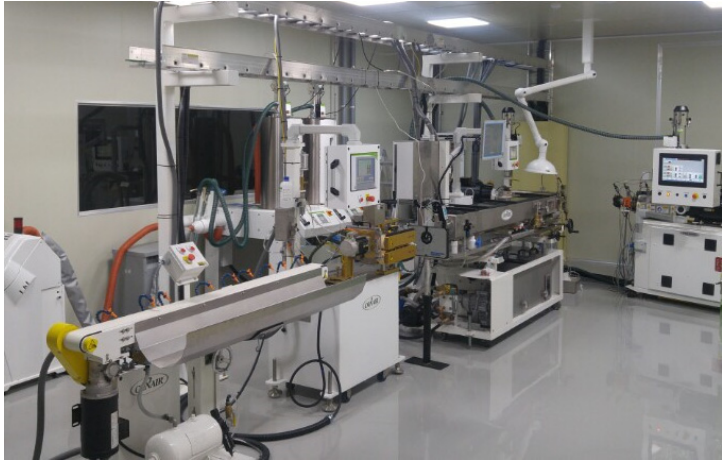
Figure 1. Medical multi ‐ lumen tubing extrusion system.